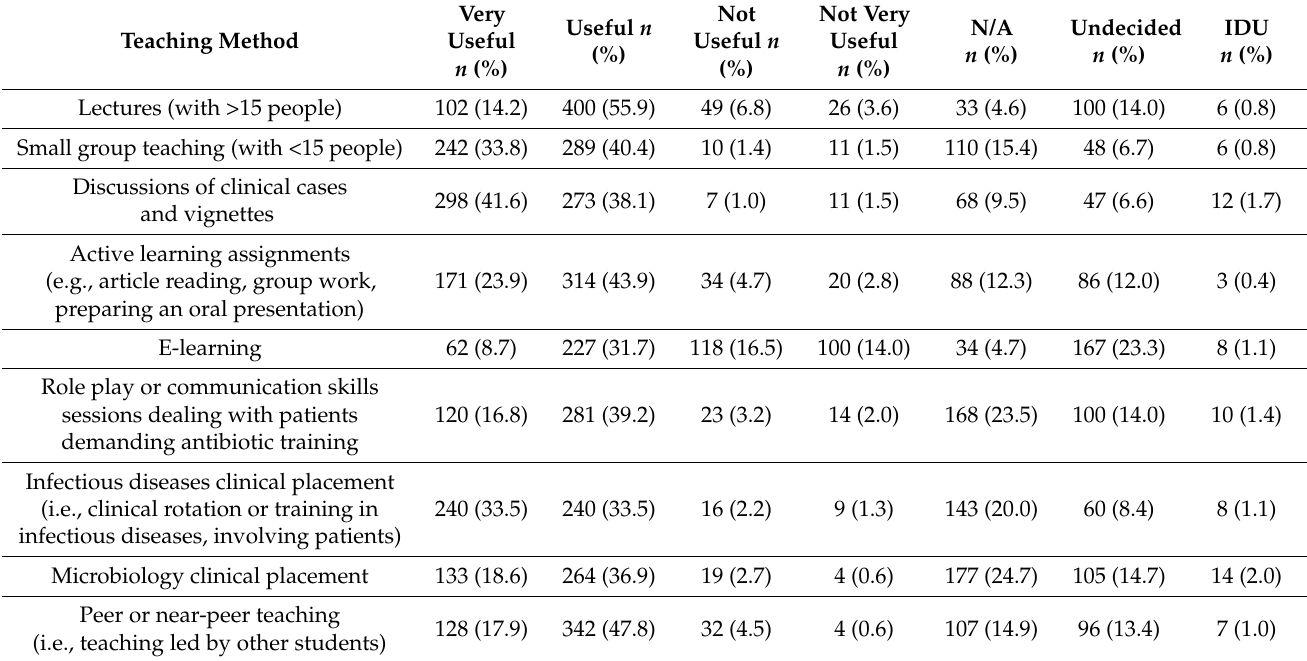
Table 9. Outcome of teaching within undergraduate study regarding antibiotic